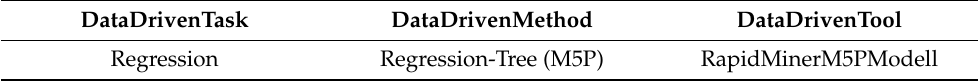
Table 3. Example output for query in Listing